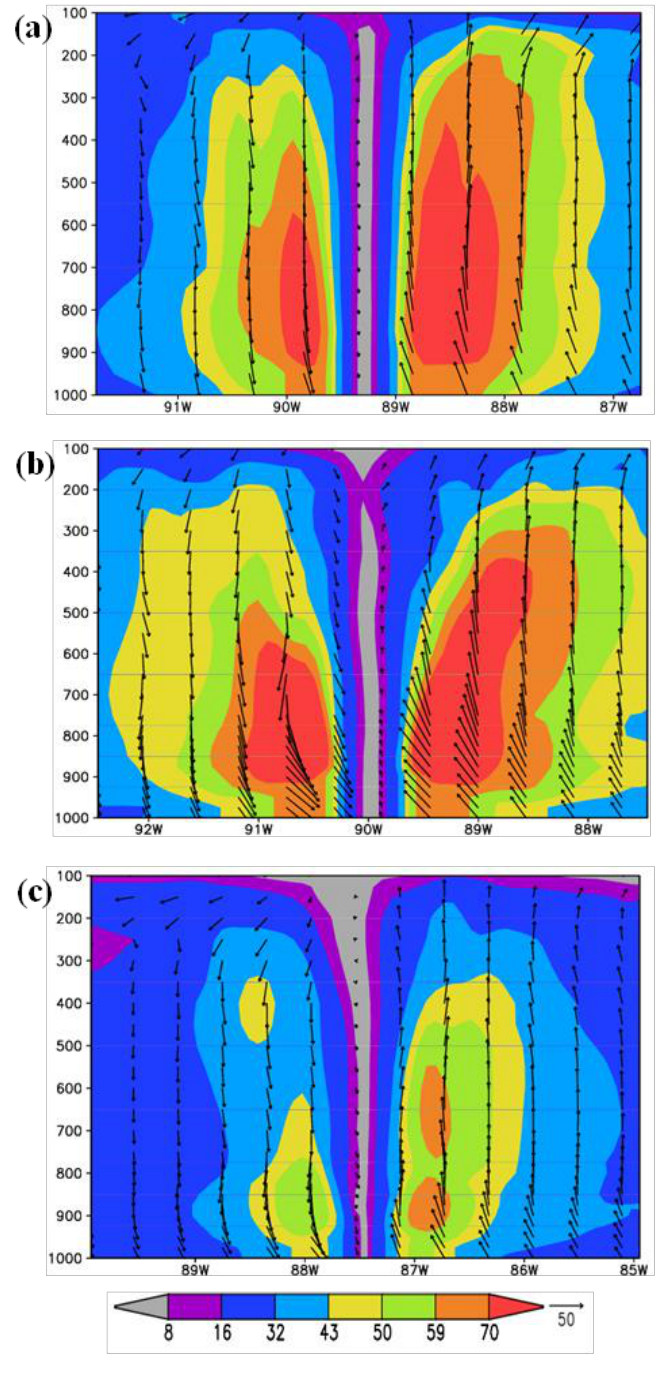
Figure 7. Longitude- vertical sections of horizontal wind with magnitude (m/s-shaded) and wind vectors (black barbs) at the mature of stage of model hurricane for (a) HWRF at 1200 UTC 28 August 2005 along 27.86N (b) ARW at 2100 UTC 28 August 2005 along 27.8757N (c) NMM at 1200 UTC 28 August 2005 along